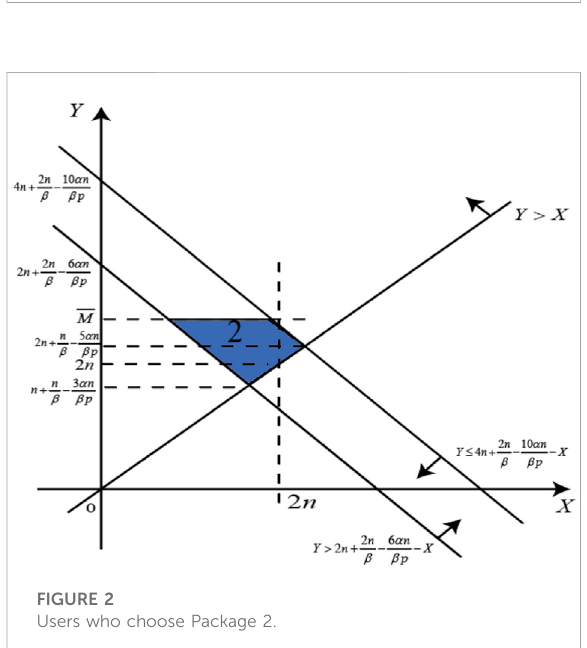
FIGURE 1 Users who choose Package 3.